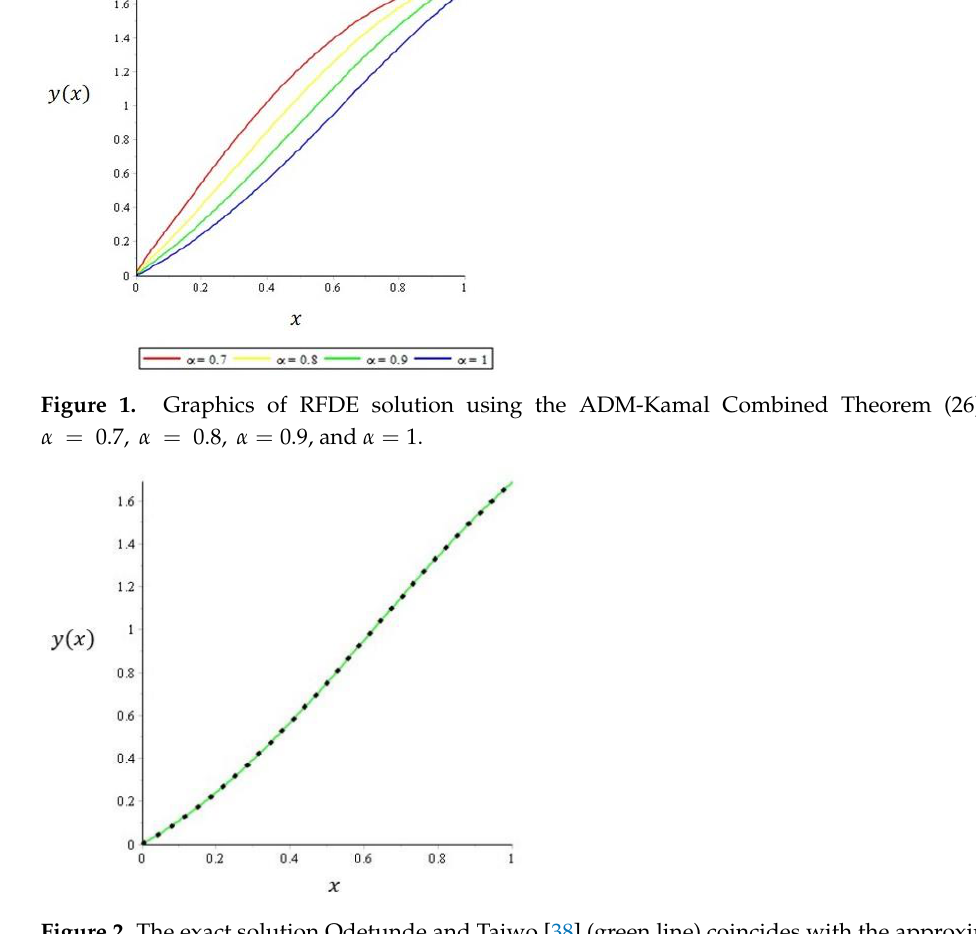
Figure 2. The exact solution Odetunde and Taiwo [38] (green line) coincides with the approximate solution using the ADM-Kamal Combined Method (black dot) for 𝛼 = 1.